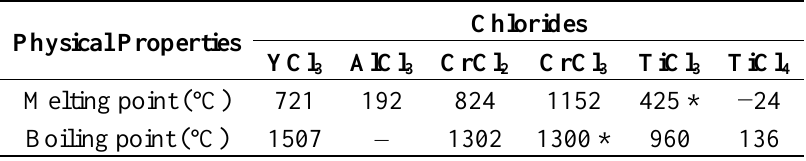
Table 1. The melting and boiling points of selected